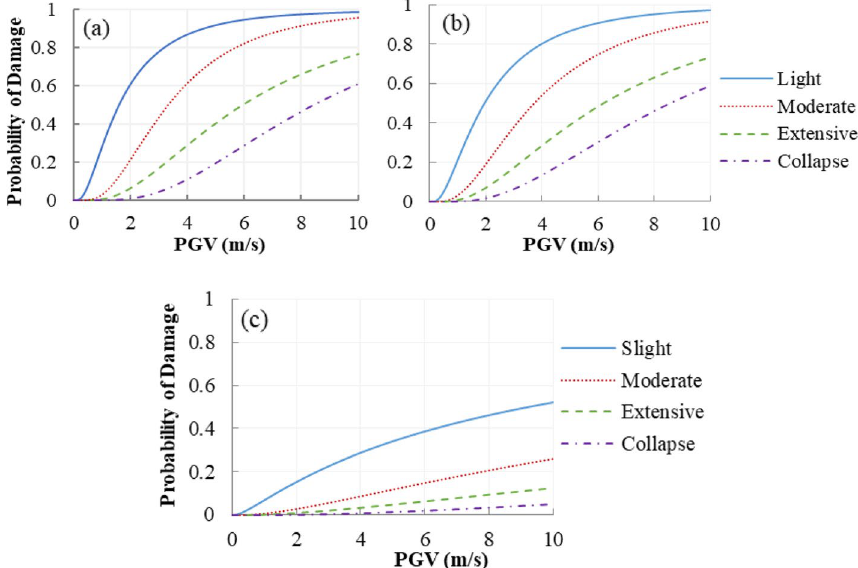
Fig. 11 Fragility curves of the bearings ( a ) Floating System, ( b ) Rigid System, and ( c )